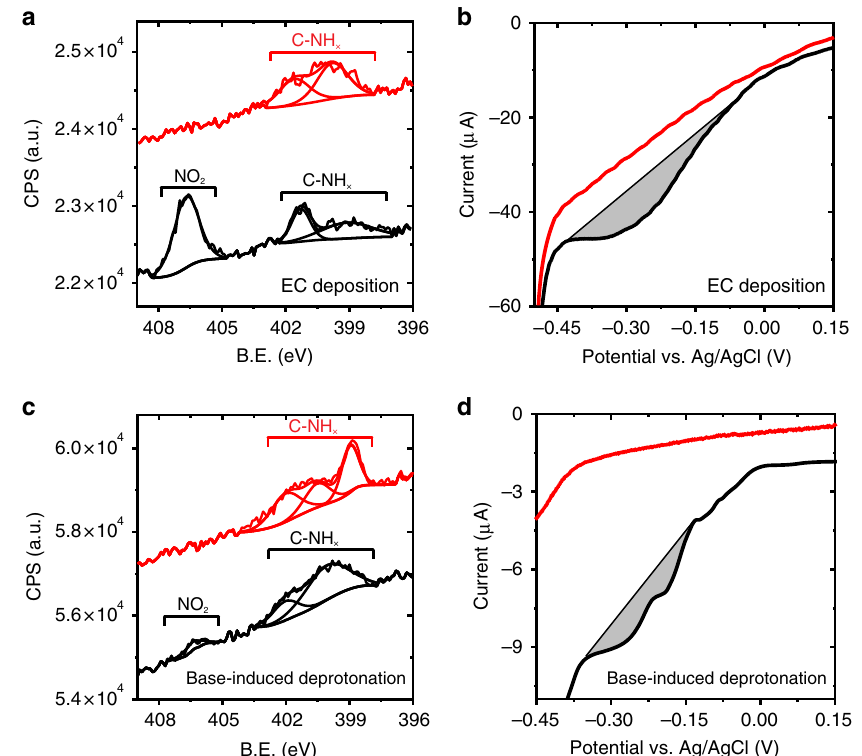
Fig. 3 Spectroscopic measurements of NO 2 -NHCs that were prepared on Au fi lm by EC deposition and base-induced deprotonation. N1 s XPS and LSV measurements of NO 2 -NHCs which were deposited on Au fi lms by EC deposition ( a and b , respectively) and base-induced deprotonation ( c and d , respectively). Measurements were performed prior (black-colored) and after (red-colored) one cycle of LSV. LSV conditions: 0.1 M HCl and scan rate of 0.1